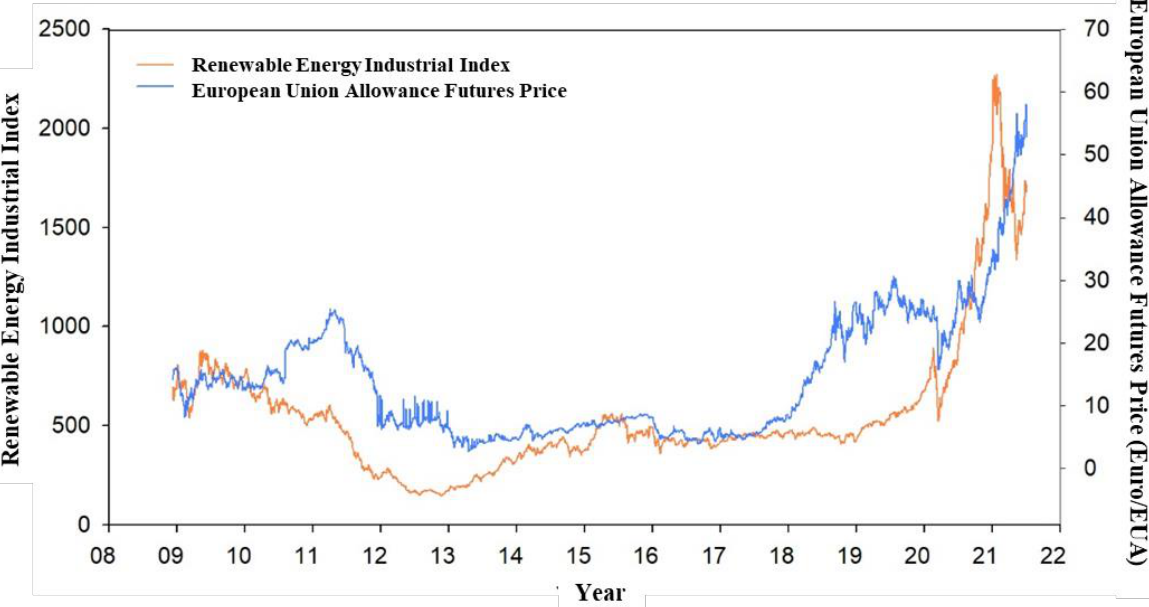
Figure A1. RENIXX and EUA Price Time Series. Note: This figure reports the time series of the Renewable Energy Industry Index (RENIXX) and European Union Allowance (EUA) future prices from 8 December 2008 to 8 July 2021. The time series is collected at daily frequency.